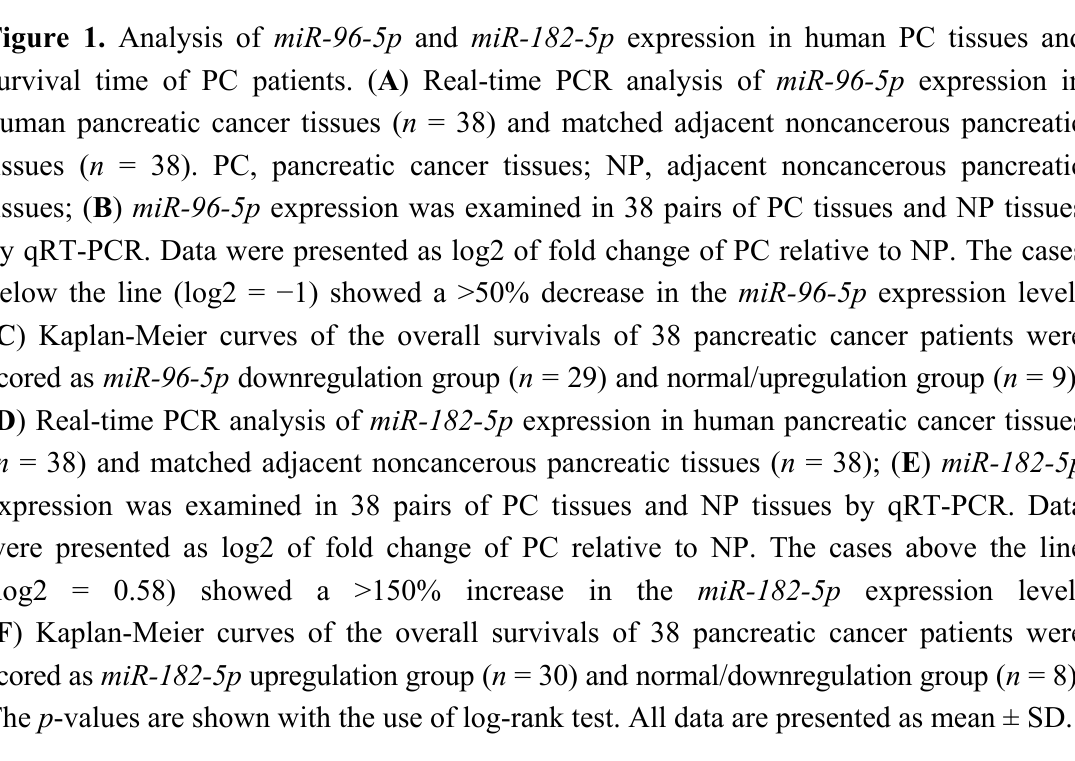
Figure 1. Analysis of miR-96-5p and miR-182-5p expression in human PC tissues and survival time of PC patients. ( A ) Real-time PCR analysis of miR-96-5p expression in human pancreatic cancer tissues ( n = 38) and matched adjacent noncancerous pancreatic tissues ( n = 38). PC, pancreatic cancer tissues; NP, adjacent noncancerous pancreatic tissues; ( B ) miR-96-5p expression was examined in 38 pairs of PC tissues and NP